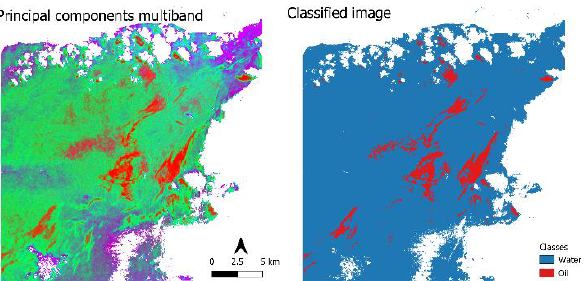
Figure 7. Multi-band composite consisting of PC1, PC2, and PC3 arranged in the following: Red: PC2, Green: PC1, and Blue: PC3. On the right is the result of pixel-based classification. The PCA multiband composite contains bright red pixels that correspond to the oil classified pixels.